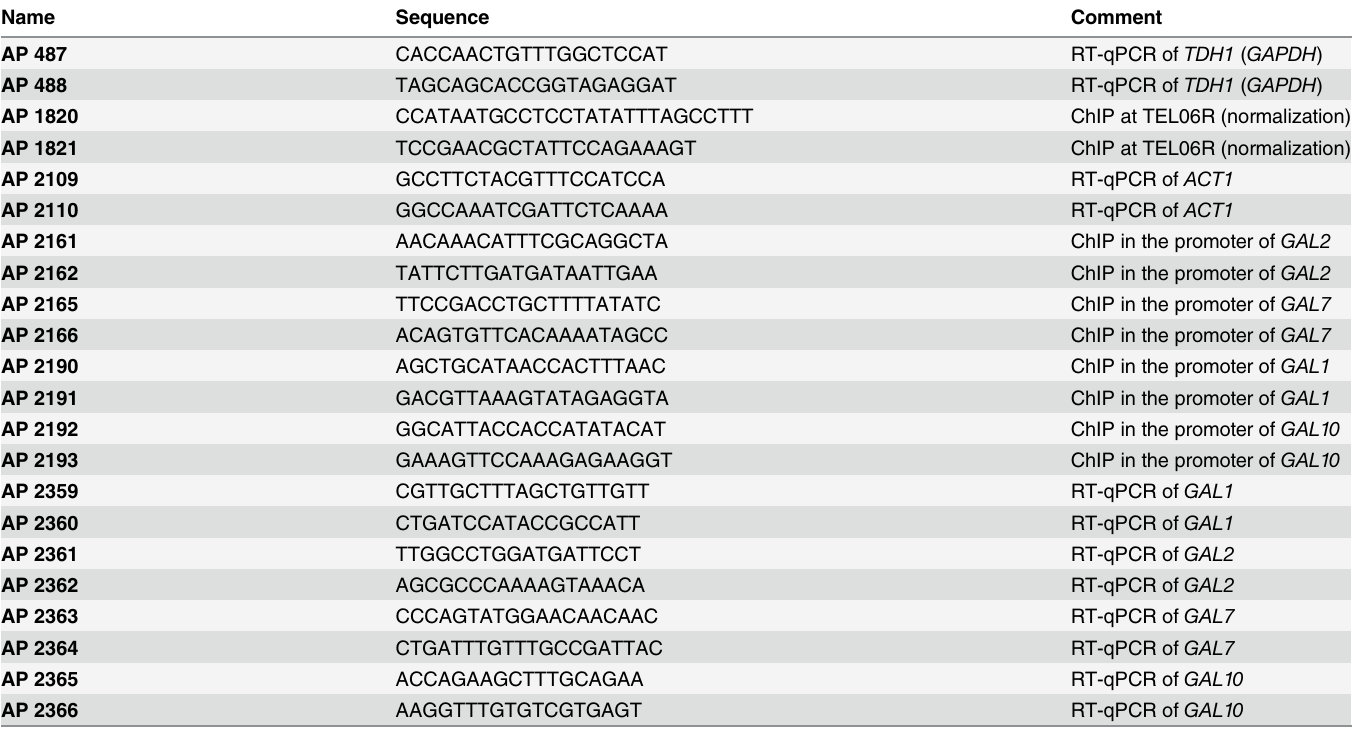
Table 2. Primers used in this